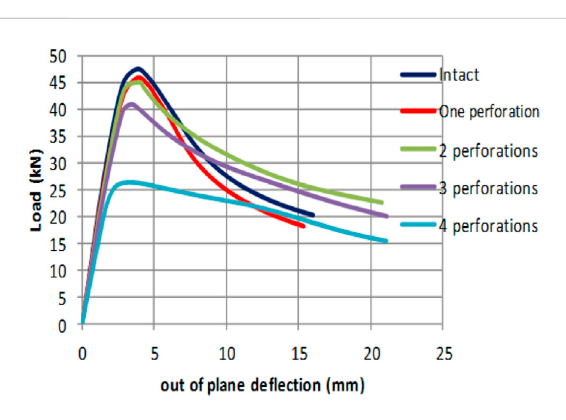
FIGURE 9 Load buckling relationship of perforated plates compared with the intact